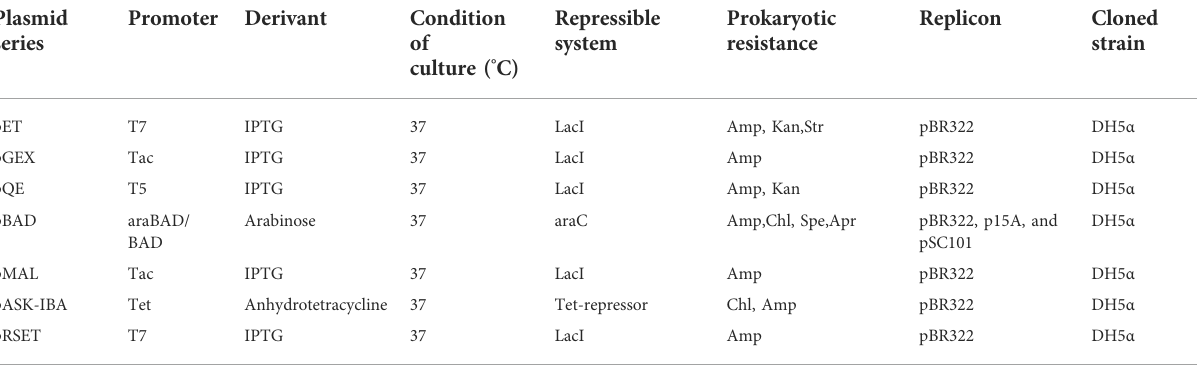
TABLE 3 Commonly used plasmids and characteristics of the E. coli expression system (Kesidis et al., 2020). Plasmid